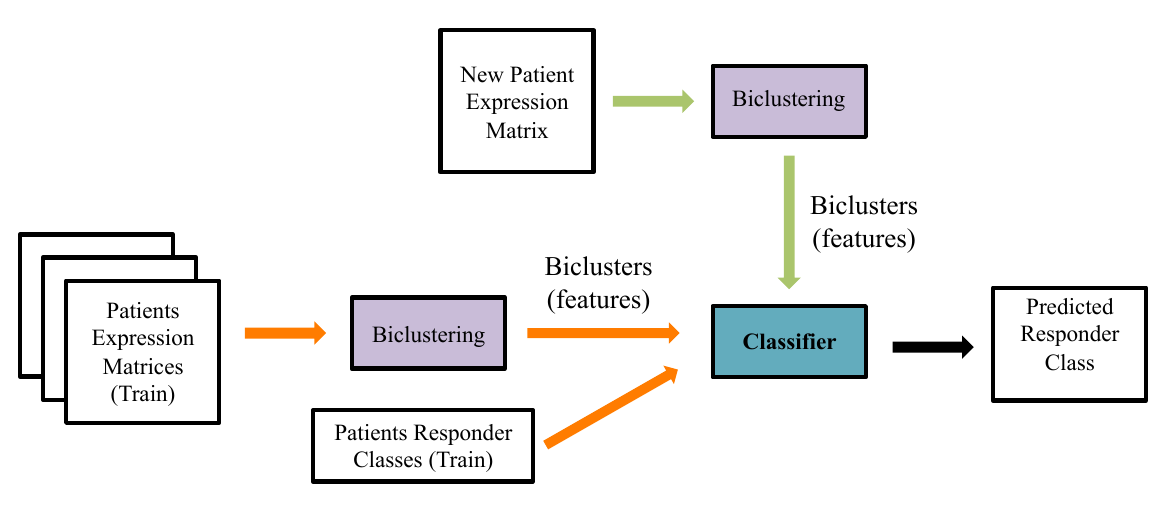
Figure 1: Basic workflow of a biclustering-based classifier.